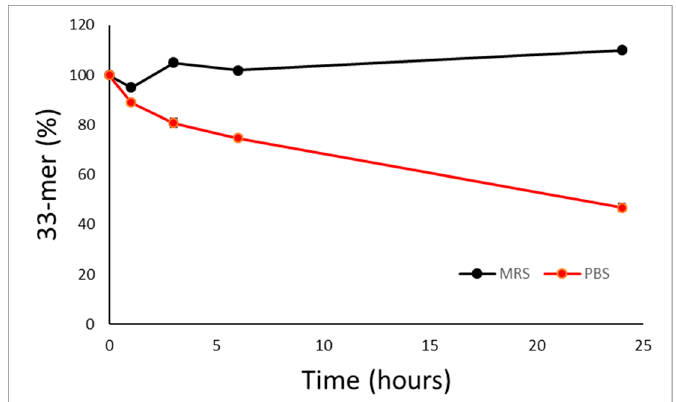
Figure 4. Kinetics of 33-mer digestion in de Man, Rogosa and Sharpe broth (MRS) or in phosphate buffered saline solution (PBS). A total of 1 mg/mL 33-mer peptide was incubated in the presence of 10 9 CFU/mL at 37 °C up to 24 h. The amount of peptide was quantified via ultraperformance liquid chromatography with diode array and mass detectors (UPLC/DAD/MS).